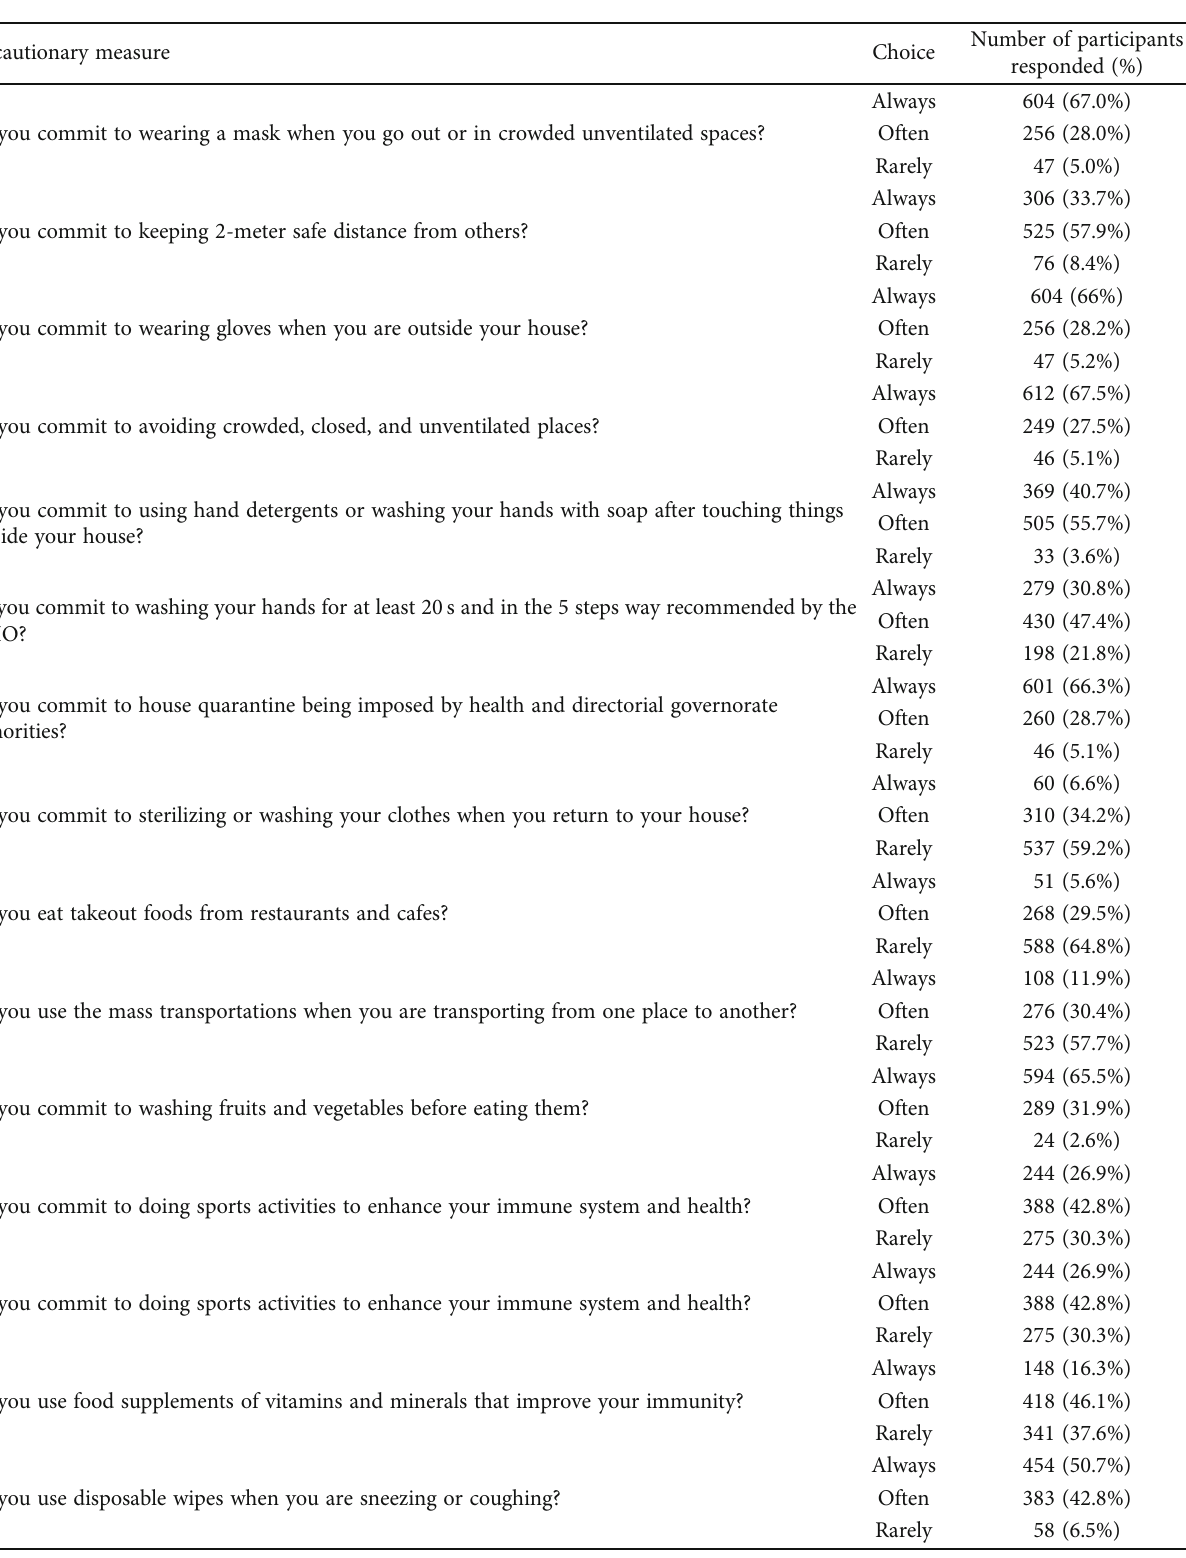
Table 3: Responses of Nineveh governorate residence to each precautionary measure recommended by the WHO and imposed by the national